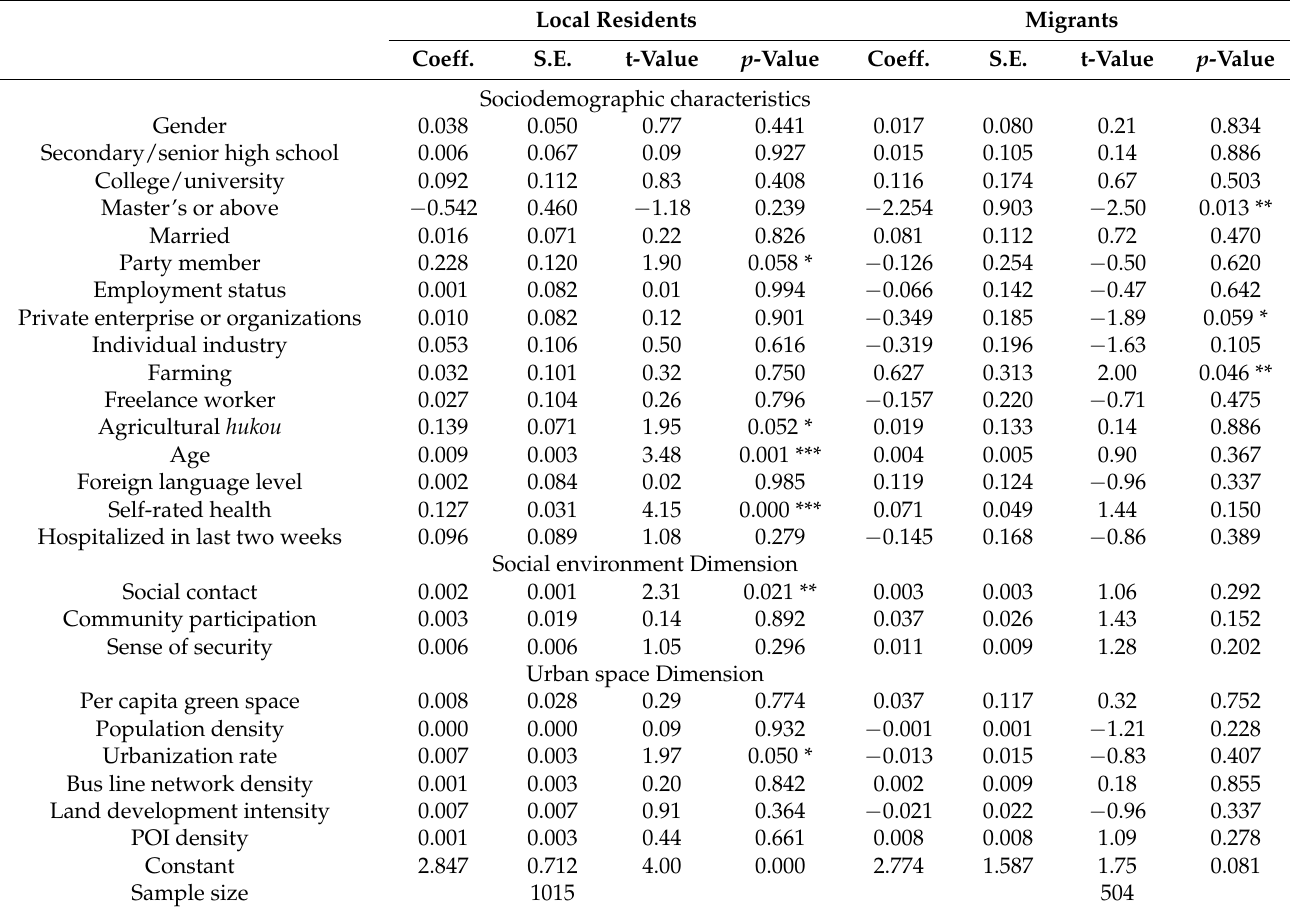
Table 4. Regression results for community trust in local residents and migrants. Local